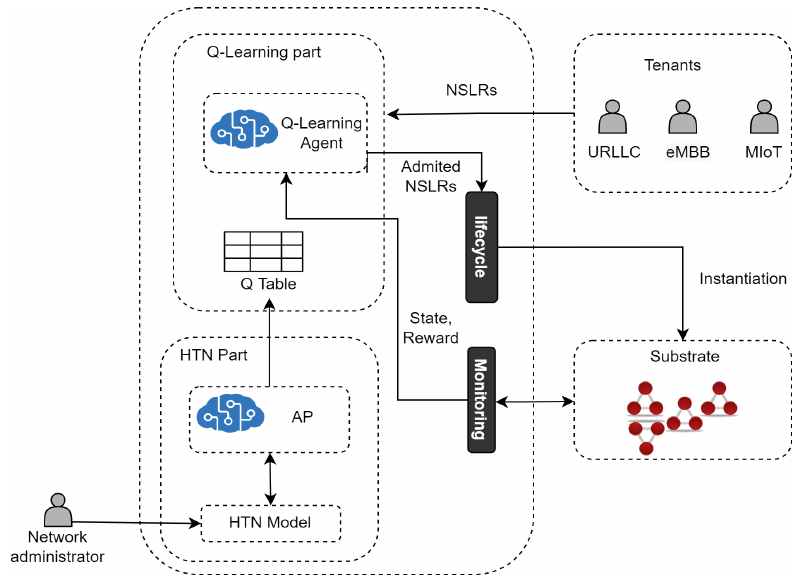
Figure 3. HTN Planning and Q-learning for Network Slicing Admission